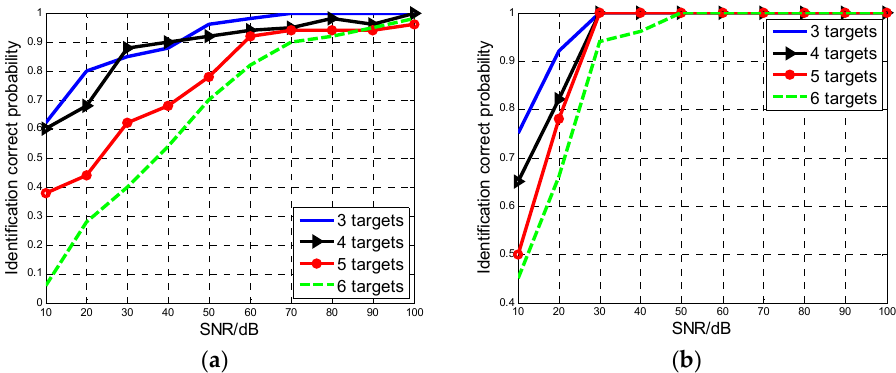
Figure 6. The correct identification probability versus MAF aircraft number. ( a ) T = 100 ms; ( b ) T = 200 ms.